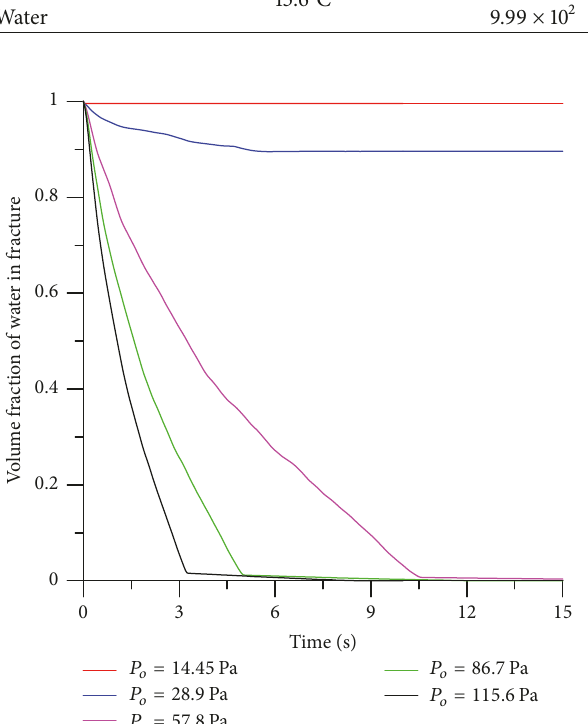
Figure 5: Volume fraction of water in fracture for different invasion pressures of crude oil.